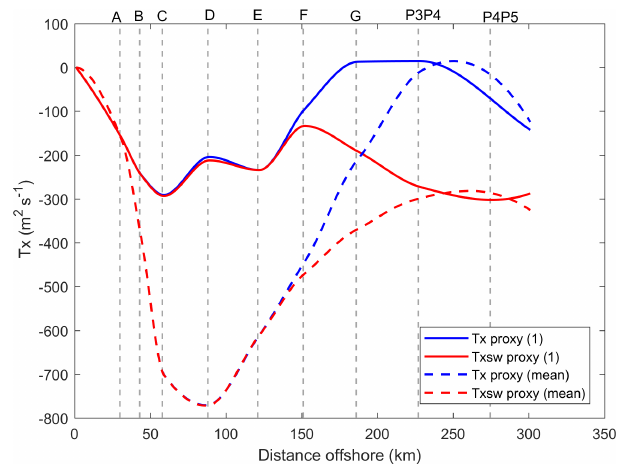
Figure 3. HYCOM transport per unit distance proxy (m 2 s − 1 ) for Tx (blue) and Txsw (red) at 1km intervals at the first model time step (solid lines) and for the ACT reference period (2010–2013, dashed lines). The dashed grey lines represent the positions of moorings and offshore CPIES